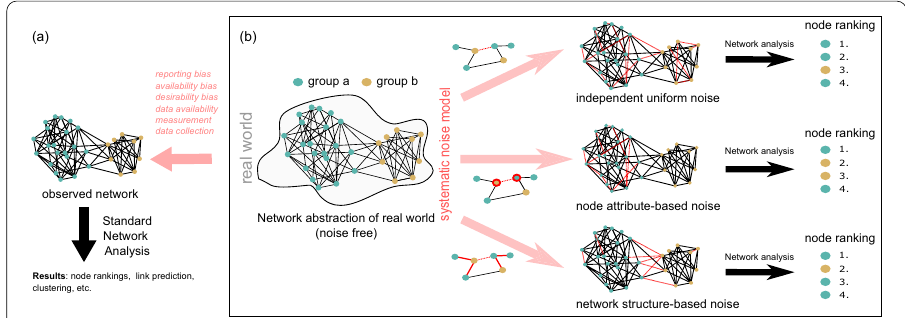
Fig. 1 Social network analysis a without and b with considering systematic noise. a A typical approach to social network analysis that implicitly assumes an observed network without noise. b Our approach allows to simulate different kinds of edge noise, which we can compare to the assumed noise-free scenario. This allows to quantify how noise can affect subsequent network analysis. In this paper we use node rankings based on degree centrality as example network analysis task. For more details of the node attribute based noise see Fig.